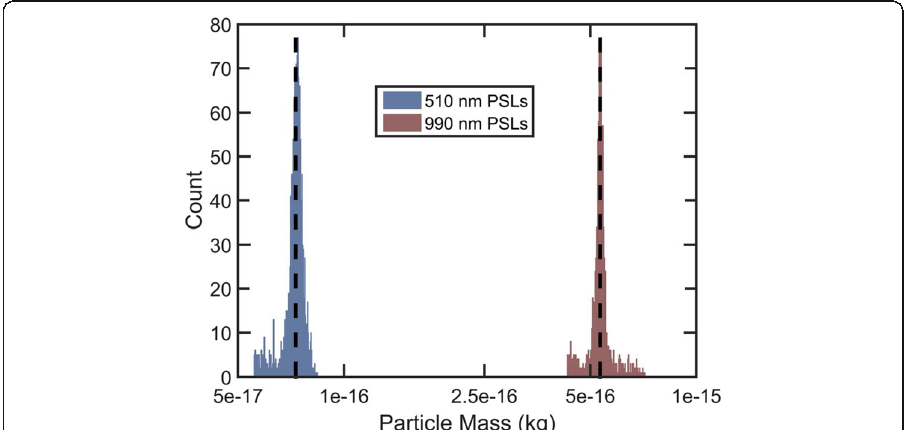
Fig. 10 Mass distribution of 510 nm PSL ( blue ) and 990 nm PSL ( red ) species, with kinetic energies of 70 eV/ z and 400 eV/z respectively. Expected mass of each species is shown in black (7.295e-17 kg for 510 nm PSLs and 5.336e-16 kg for 990 nm PSLs). For the presented histogram, 510 nm particles whose mass is more than ±1.3 σ from the mean are rejected, and 990 nm particles whose mass is more than ±0.8 σ from the mean are